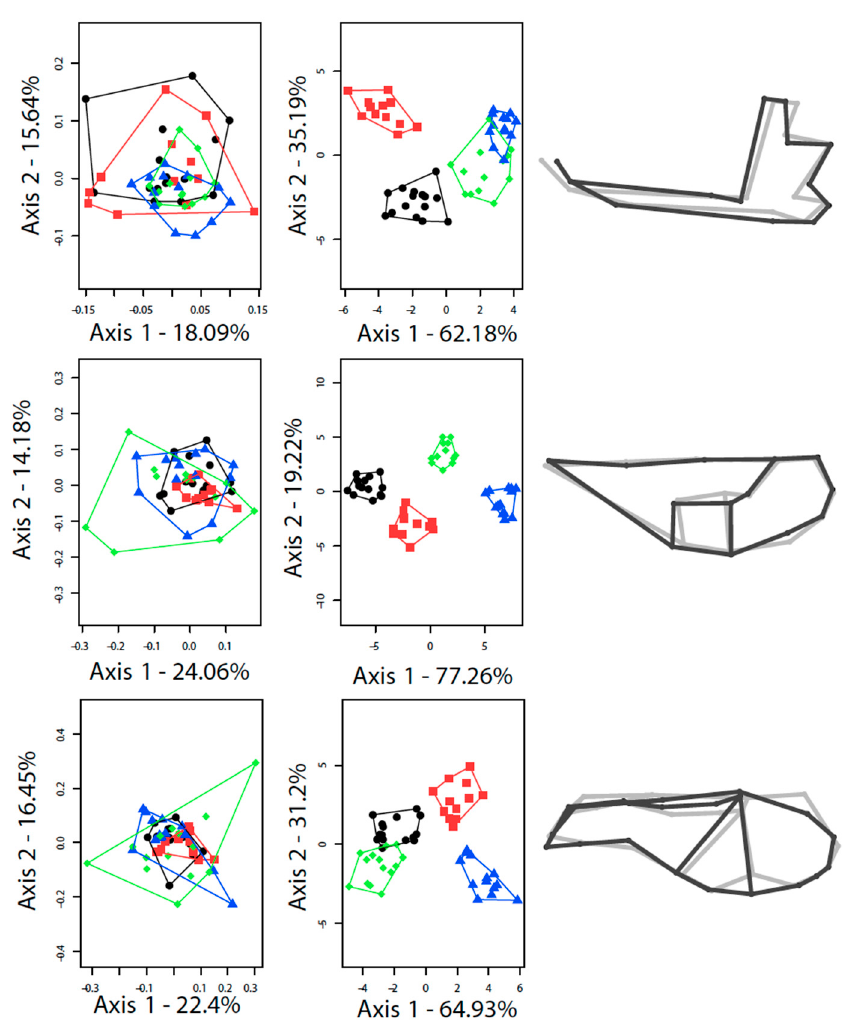
Figure 4. Principal component analysis (PCA; left section), discriminant analysis (DA; central section) and visualisation of the differences in shape between the two species (right section) in relation to mandible (top), ventral side (middle) and dorsal side (bottom). For PCA and DA, black stands for E . europaeus in allopatry, green for E. europaeus in sympatry, red for E. roumanicus in allopatry, blue for E. roumanicus in sympatry. For shape comparison, black stands for E. roumanicus and grey for E. europaeus ; shape differences are amplified by a factor of 5.